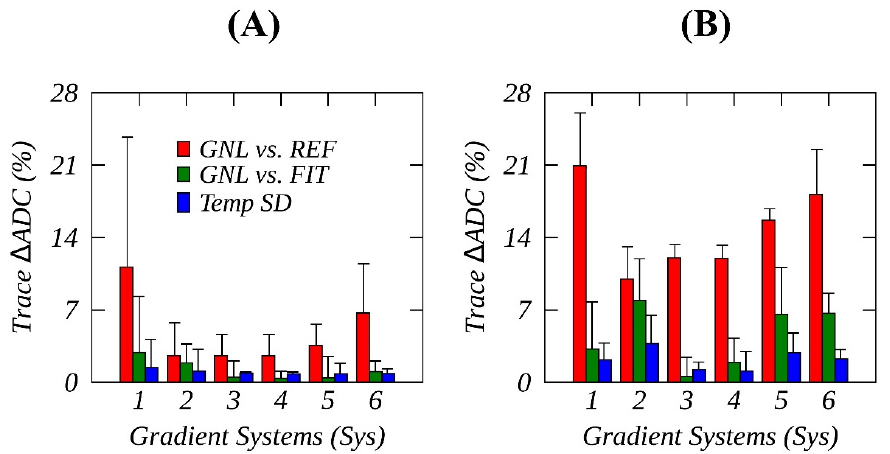
Figure 4. Root-mean-squared (RMS)% deviations (within ± 18 cm), normalized by an ice-water apparent diffusion coefficient (ADC) reference (REF), are shown for predicted system model gradient nonlinearity (GNL) versus REF (red bars), GNL versus temporal mean fit (green bars), and temporal fit SD (blue bars) for trace ADCs, measured for horizontal offsets ( A ) and along the magnet bore ( B ) for six studied MR systems (Sys1-6, the error bars denote the largest RMS% observed among three physical gradient channels on a specific MR system, see Table 1).